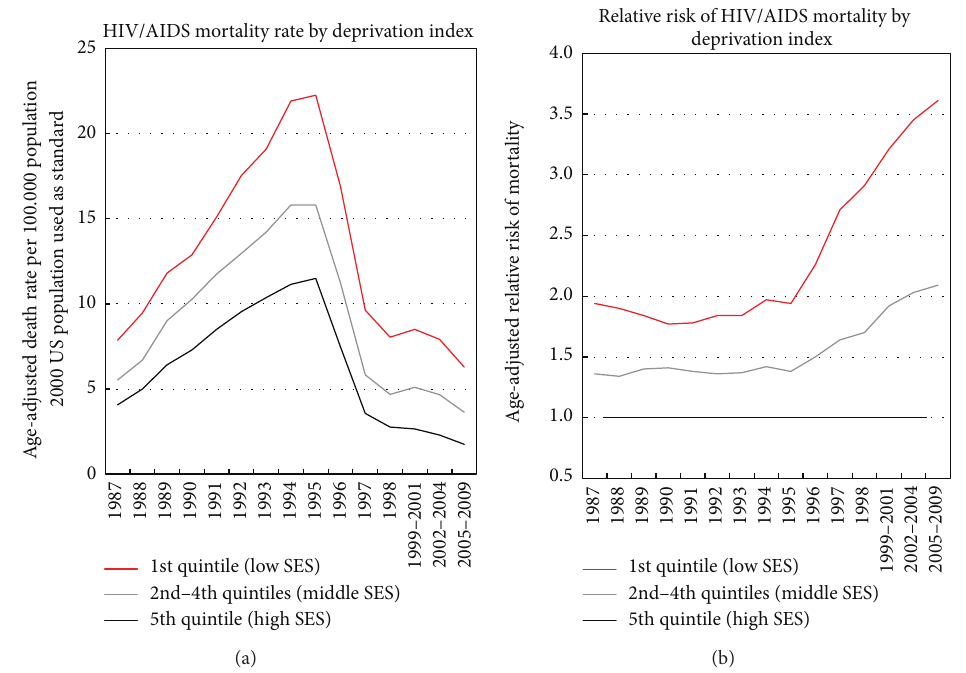
Figure 3: Trends in HIV/AIDS mortality by area socioeconomic deprivation index, both sexes combined, United States 1987–2009.